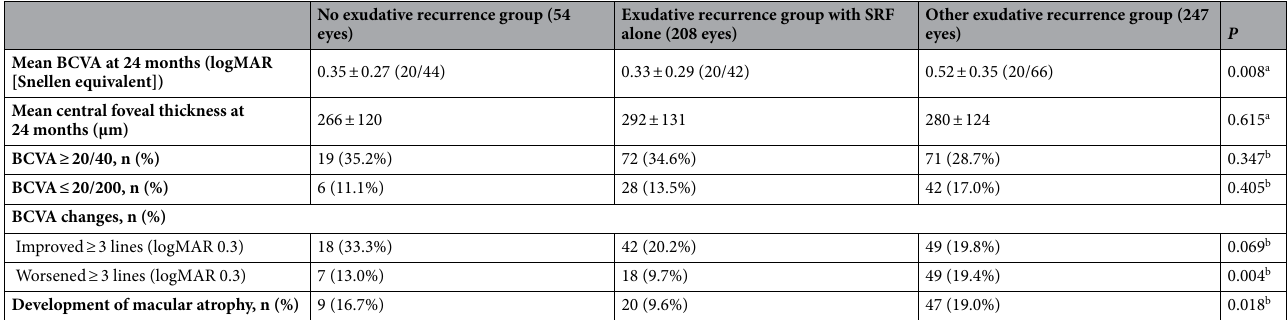
Table 2. Comparisons of treatment outcome according to exudation features during the 2-year anti-VEGF treatment. a Based on one-way analysis of variance. b Based on chi-square test. BCVA, best-corrected visual acuity; logMAR, logarithm of the minimum angle of resolution; SRF, subretinal fluid; VEGF, vascular endothelial growth factor.